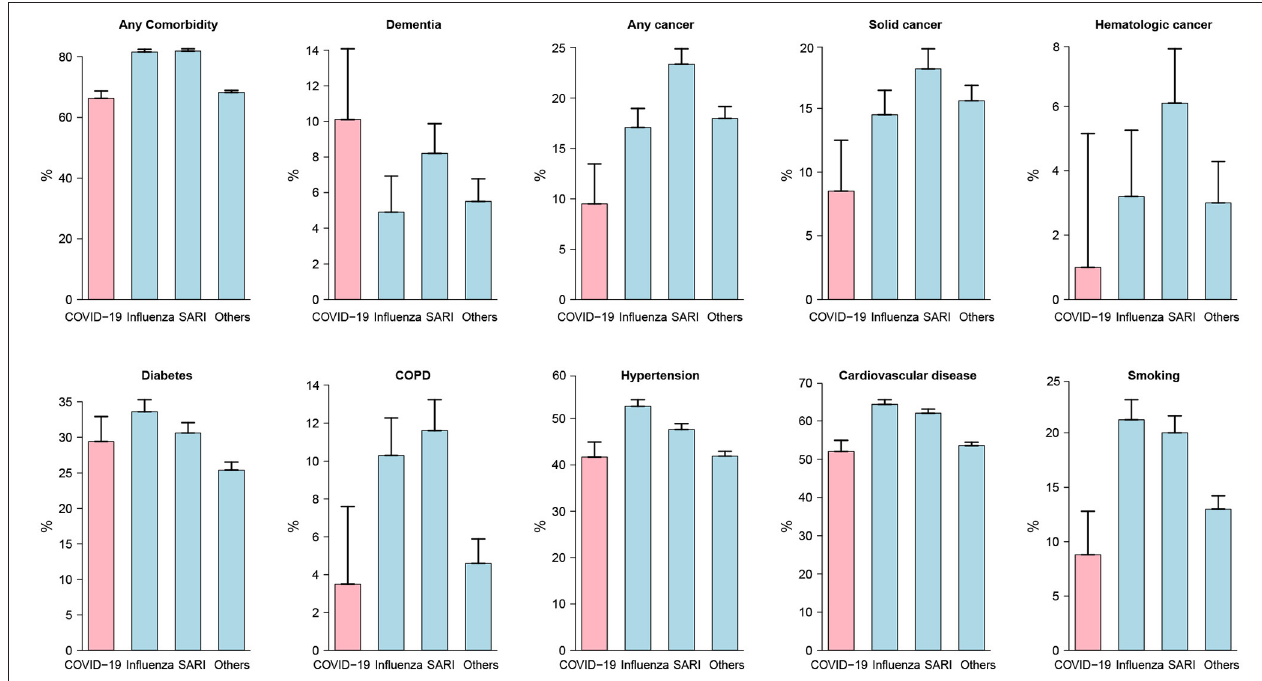
FIGURE 2 | Comorbidity prevalence rates among study patients at admission. Moderate to severe cases were considered for COVID-19 patients. For all disease types but dementia, rates were lower among COVID-19 patients compared to other patients. The differences between disease groups were all statistically significant except for